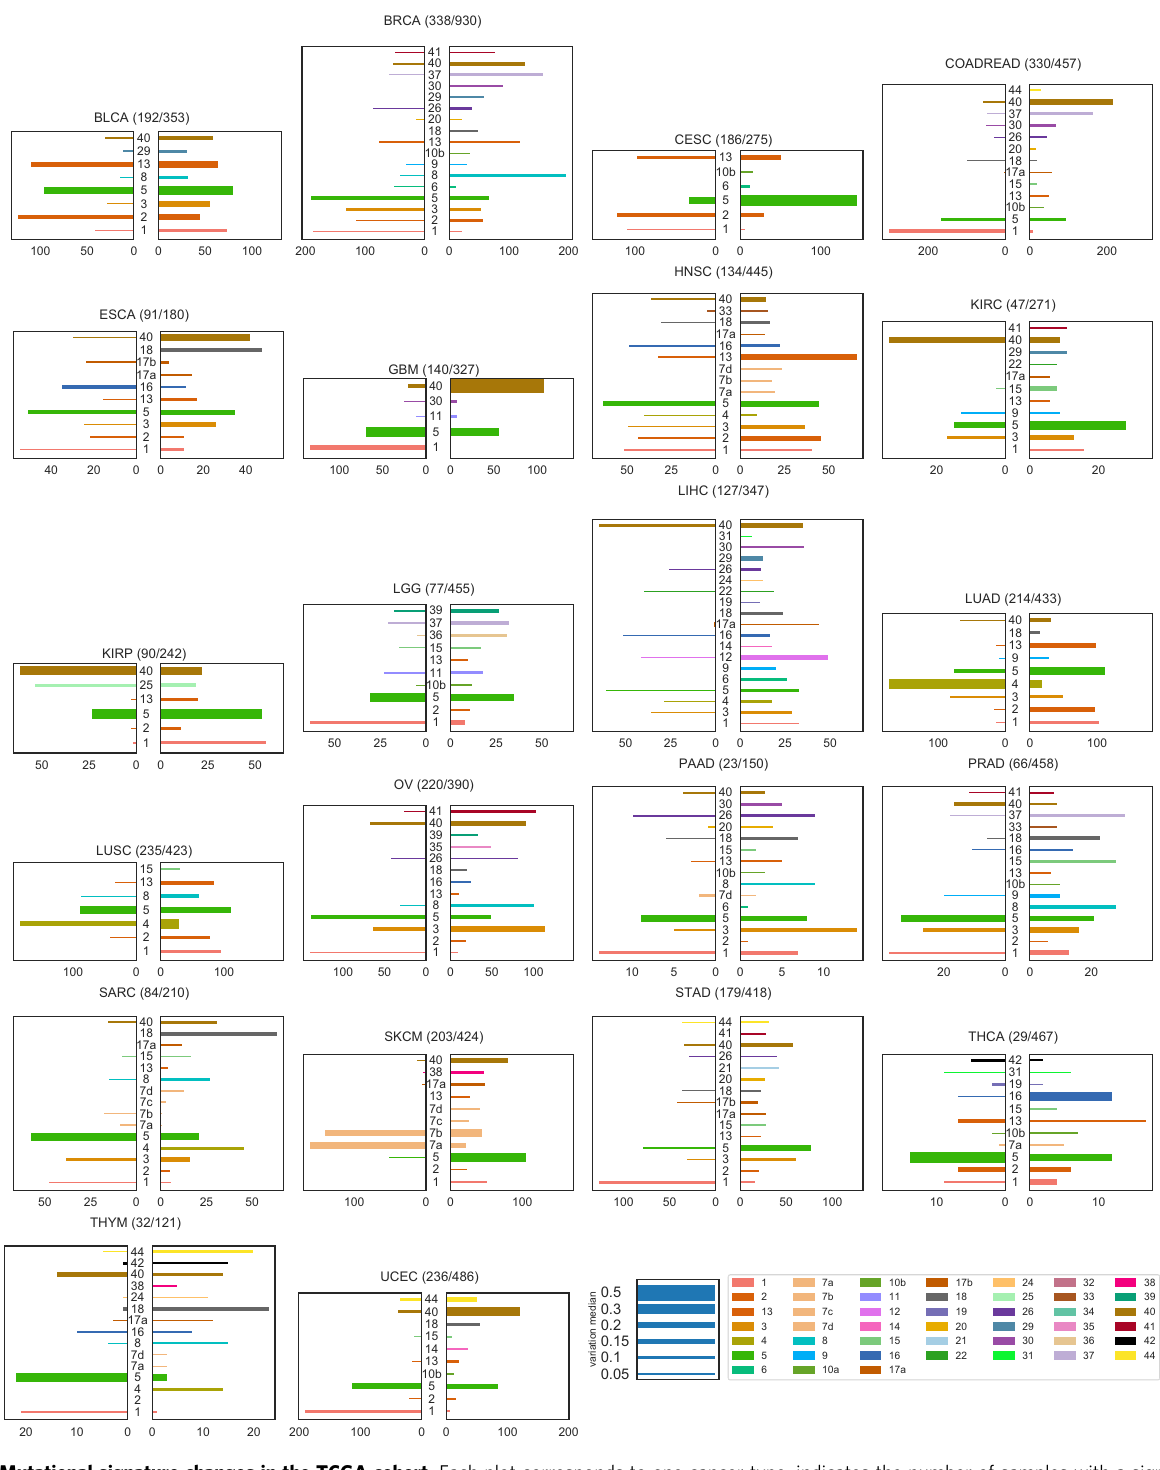
Fig. 6 Mutational signature changes in the TCGA cohort. Each plot corresponds to one cancer type, indicates the number of samples with a signi fi cant signature change compared to the total number of samples, and shows on the right panel an increase of a signature in the largest subclone, compared to clonal mutations, and on the left panel a decrease. The length of each bar corresponds to the number of patients with such changes, and the thickness to the median absolute observed change. Only the 22 cancer types with more than 100 patients are represented: bladder urothelial carcinoma (BLCA), breast invasive carcinoma (BRCA), cervical squamous cell carcinoma and endocervical adenocarcinoma (CESC), colorectal adenocarcinoma (COADREAD), esophageal carcinoma (ESCA), glioblastoma multiforme (GBM), head and neck squamous cell carcinoma (HNSC), kidney renal clear cell carcinoma (KIRC), kidney renal papillary cell carcinoma (KIRP), brain lower grade glioma (LGG), liver hepatocellular carcinoma (LIHC), lung adenocarcinoma (LUAD), lung squamous cell carcinoma (LUSC), ovarian serous cystadenocarcinoma (OV), pancreatic adenocarcinoma (PAAD), prostate adenocarcinoma (PRAD), sarcoma (SARC), skin cutaneous melanoma (SKCM), stomach adenocarcinoma (STAD), thyroid carcinoma (THCA), thymoma (THYM), uterine corpus endometrial carcinoma (UCEC). Full results for all cancer types are available in Supplementary Note 3. Source data are provided as a Source Data fi